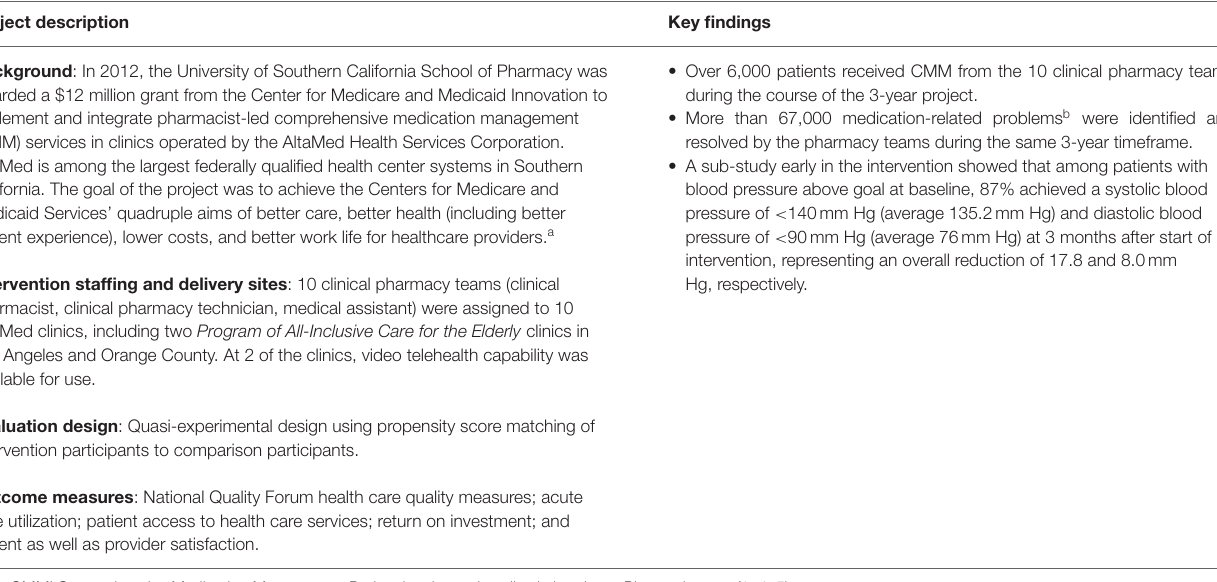
TABLE 1 | Centers for Medicare and Medicaid Services Innovations Health Care Innovation Award: the Comprehensive Medication Management Project, University of Southern California School of Pharmacy and AltaMed Health Services Corporation, 2012–2015. Project